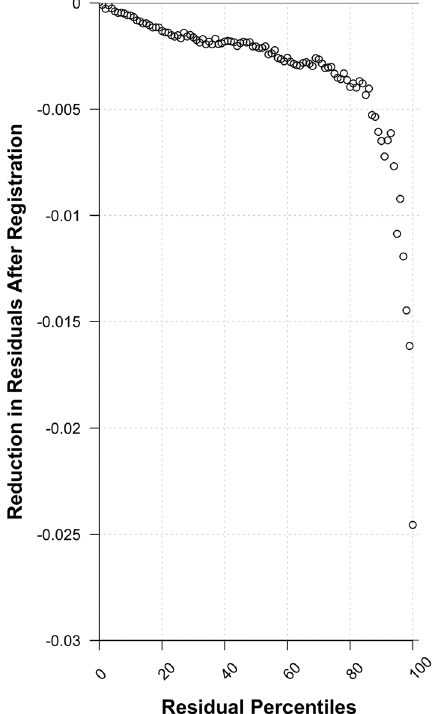
Fig. 5 Impact of registration on residuals by intralesion percentiles. Difference in voxel-wise residuals from perfusion model fitting using the extended Tofts model. Registration resulted in a reduction in residuals, which was especially pronounced in areas with high residual errors prior to registration (around the 80th percentile and